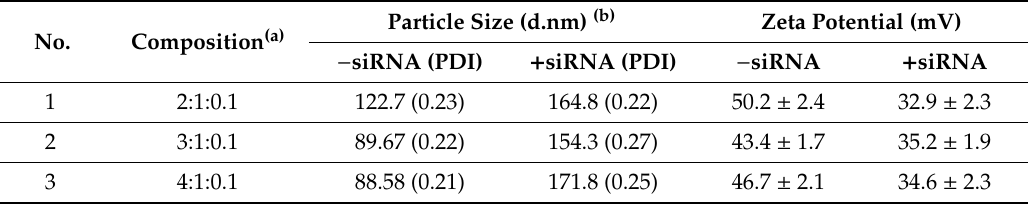
Table 2. Particle size and zeta potential of DoCh formulations before and after siRNA loading.